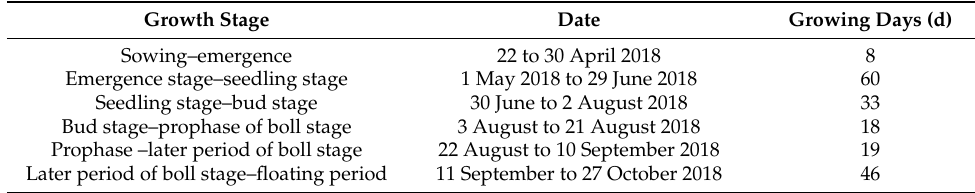
Table 2. Divisions of cotton birth